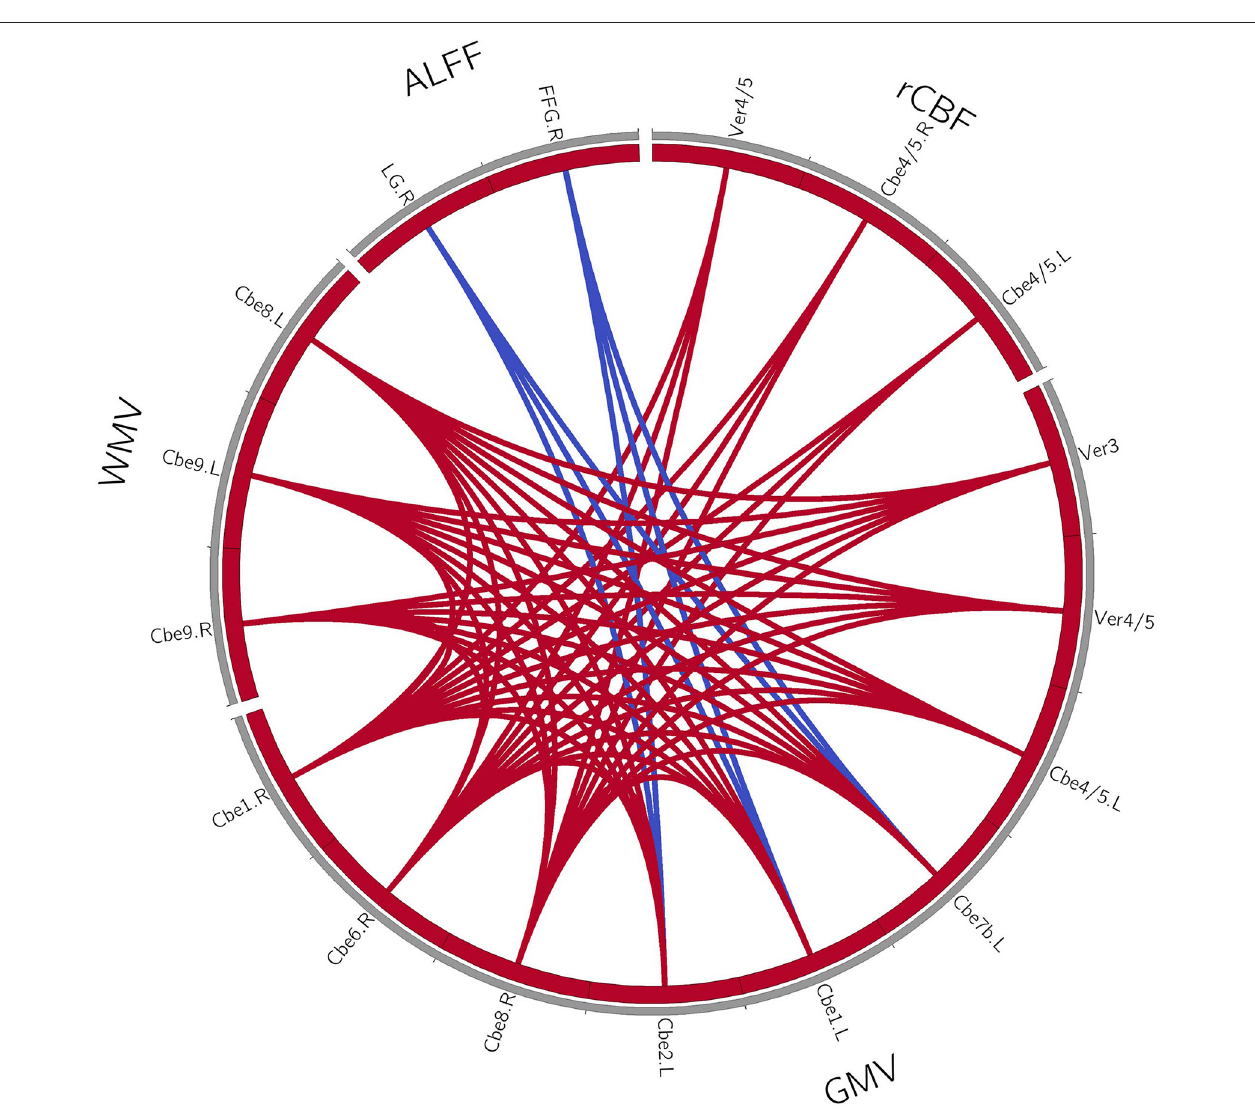
FIGURE 2 | Coupling relationships among perfusion, structure, and function in patients with MSA-c type. For patients with MSA-c type, we found positive correlations within the structure changes, and positive correlations between the decreased rCBF and decreased GM volumes. Furthermore, negative correlations between the ALFF and GM volumes were found. The red line denotes the increased correlations, and the blue line denotes the decreased correlations. GMV, gray matter volume; WMV, white matter volume; rCBF, regional cerebral blood flow; ALFF, amplitude of low-frequency fluctuations; L, left; R, right; Cbe, cerebellum; Ver, vermis; LG, lingual gyrus; FFG,